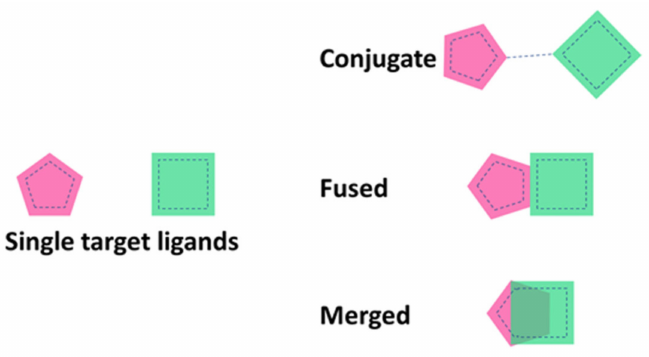
Figure 3. Di ff erent strategies to design multi-target